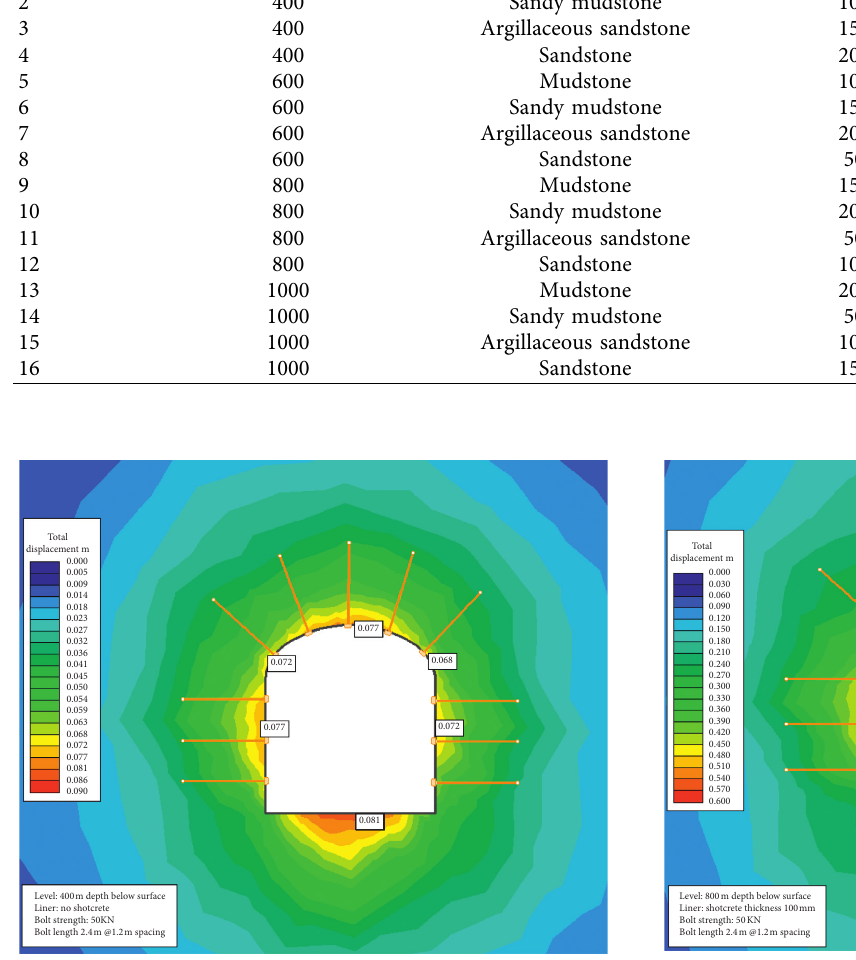
Figure 5: Displacement of scheme 1.